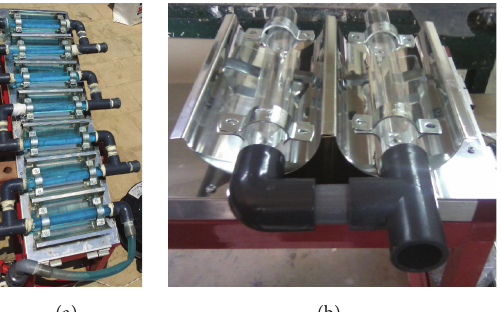
Figure 2: Fabricated bench-scale CPC photoreactor was used in this work. It contains seven low iron borosilicate tubes connected in series (a). Each tube was fixed on a reflector fabricated from stainless steel grade 304 (b). T connectors were used to obtain a flexible lab-scale system (use only one tube or more and withdrawing sample at any tube is possible). The simulated wastewater is fed from the lower tube to the upper one against the gravity using centrifuge pump connected to 4-L stirrer tank (not shown). The output treated wastewater was circulated to the tank (closed system). TiO 2 immobilized on PET sheets were wrapped on temperature-resistant removable Teflon rods hanged in the middle of each glass